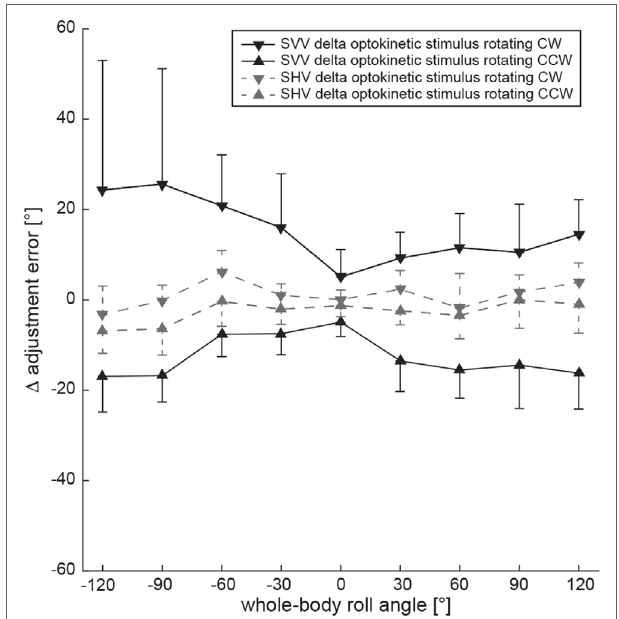
FigUre 4 | Overall mean individual differences ( Δ ) in adjustment errors ( ± 1SD) after subtracting baseline adjustments from the test adjustments for both the SVV (black symbols, interconnected by a solid black line) and the subjective haptic vertical (SHV) (gray symbols, interconnected by a dashed gray line) paradigm are plotted against whole-body roll orientation. Whereas triangles refer to test trials with CCW optokinetic stimulation, inverted triangles refer to test trials with CW optokinetic stimulation.